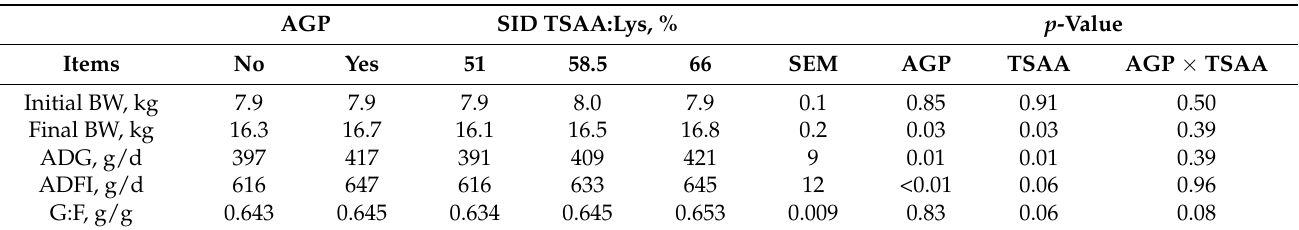
Table 3. Effect of antibiotic growth promoter (AGP) and standardized ileal digestible (SID) total sulfur amino acids to lysine ratio (TSAA:Lys) on growth performance of nursery pigs (factorial analysis, Experiment